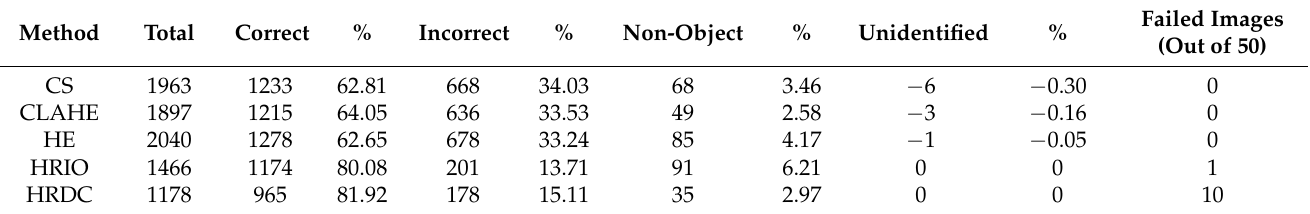
Table 4. Object identification results from 50 photogrammetry